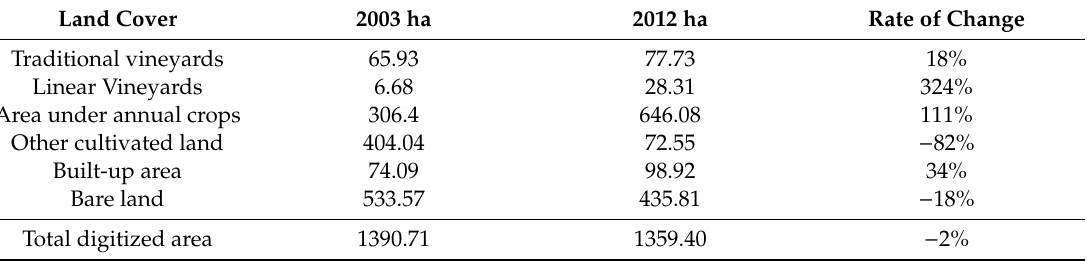
Table 2. Area under each land cover class for 2003 and 2012 (in